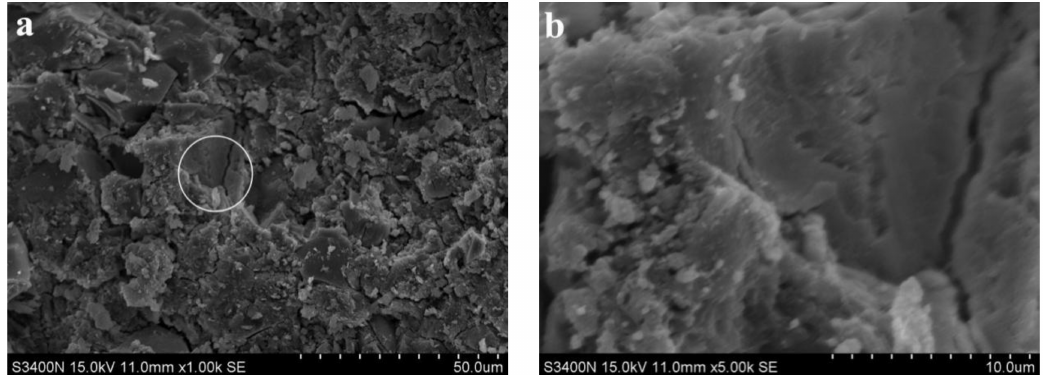
Figure 5. SEM images of the alkali slag cement slurry with pure ore powder at the hydration age of 3 d.